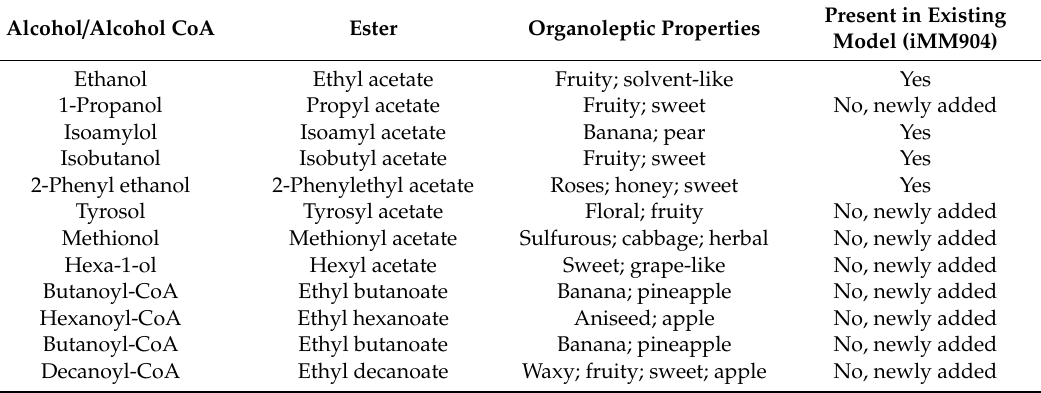
Figure 1. Representation of the the components of the yeast genome-scale metabolic model (GSMM) related to aroma formation. Each colored section shows metabolism related to a respective class of aroma compounds, including the expanded pathways related to amino acid and fatty acid degradation and sulfur reduction pathways, as well as formation of fusel alcohols, esters, and sulfur compounds in yeast model metabolism. The entire metabolic network utilized is shown in the Supplementary Material (Figure S2). Table 1. Significant higher alcohols or alcohol Coenzyme As (CoAs) and respective esters relevant to wine